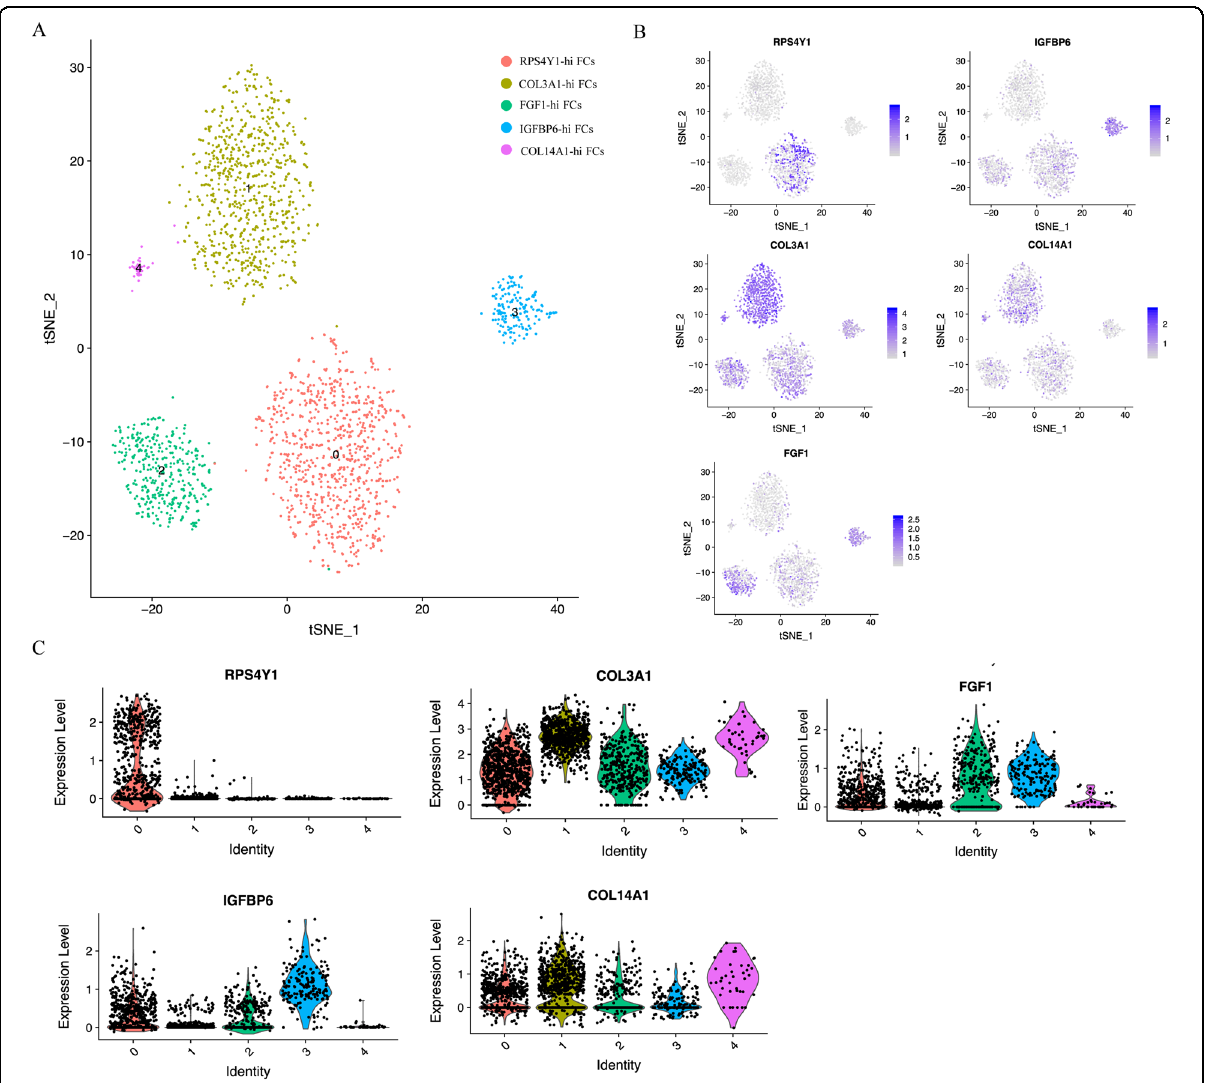
Fig. 6 Recluster analysis of fi brocartilage chondrocytes. A Visualisation of reclustering by t-SNE plot of the original clusters 3 and 4, identi fi ed by cell type. B T-SNE plots demonstrating gene expression of markers used to identify the cell identity of each cluster. Dot colour corresponds to the level of gene expression in each cell. C Violin plots of gene expression of chondrocyte markers by reclustering original fi brocartilage